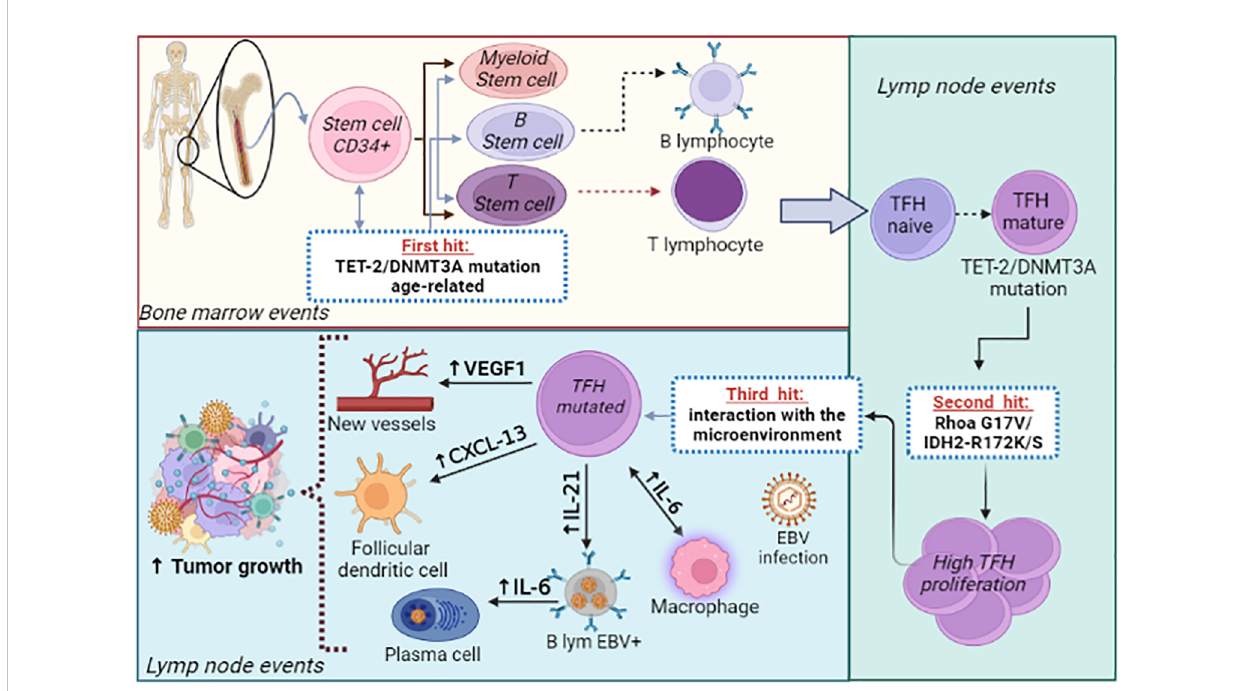
FIGURE 1 Integrative biologic model for AITL pathogenesis. AITL development follows a “ multi-step ” process. The initiating event of neoplasia ( “ fi rst-hit ” ) involves age-related mutations in epigenetic regulatory genes ( TET-2 and/or DNMT3A ) that compromise the pluripotent hematopoietic stem cells- CD34+ with propagation to myeloid precursor cells, B- and T-lymphoid cells. Subsequently, the naïve T-CD4+ cell matures to TFH-cell in the germinal center and experiences speci fi c-disease ( “ driver ” ) mutations, such as the RhoA G17V and/or IDH-2 R172 K/S ( “ second-hit ” ). Finally, mature and mutated TFH-cells expand in the germinal center from the interaction with several elements of the tumor immune microenvironment (FDC, macrophages, B-cells, endothelial-cells and EBV), which provide an environment marked by immune-dysregulation and pro-in fl ammatory activity, highly permissive for the propagation and dissemination of the neoplasm ( “ third -hit ”